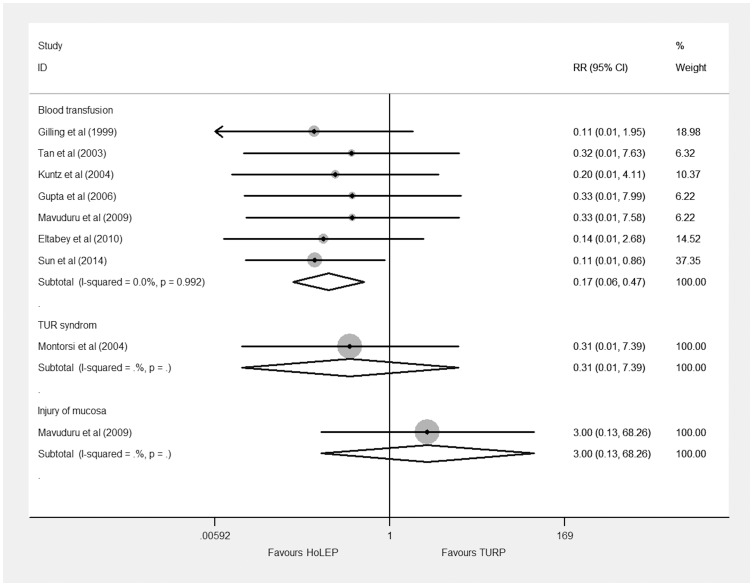
Forest plot for intraoperative complications.RR = relative risk; CI = confidence interval.